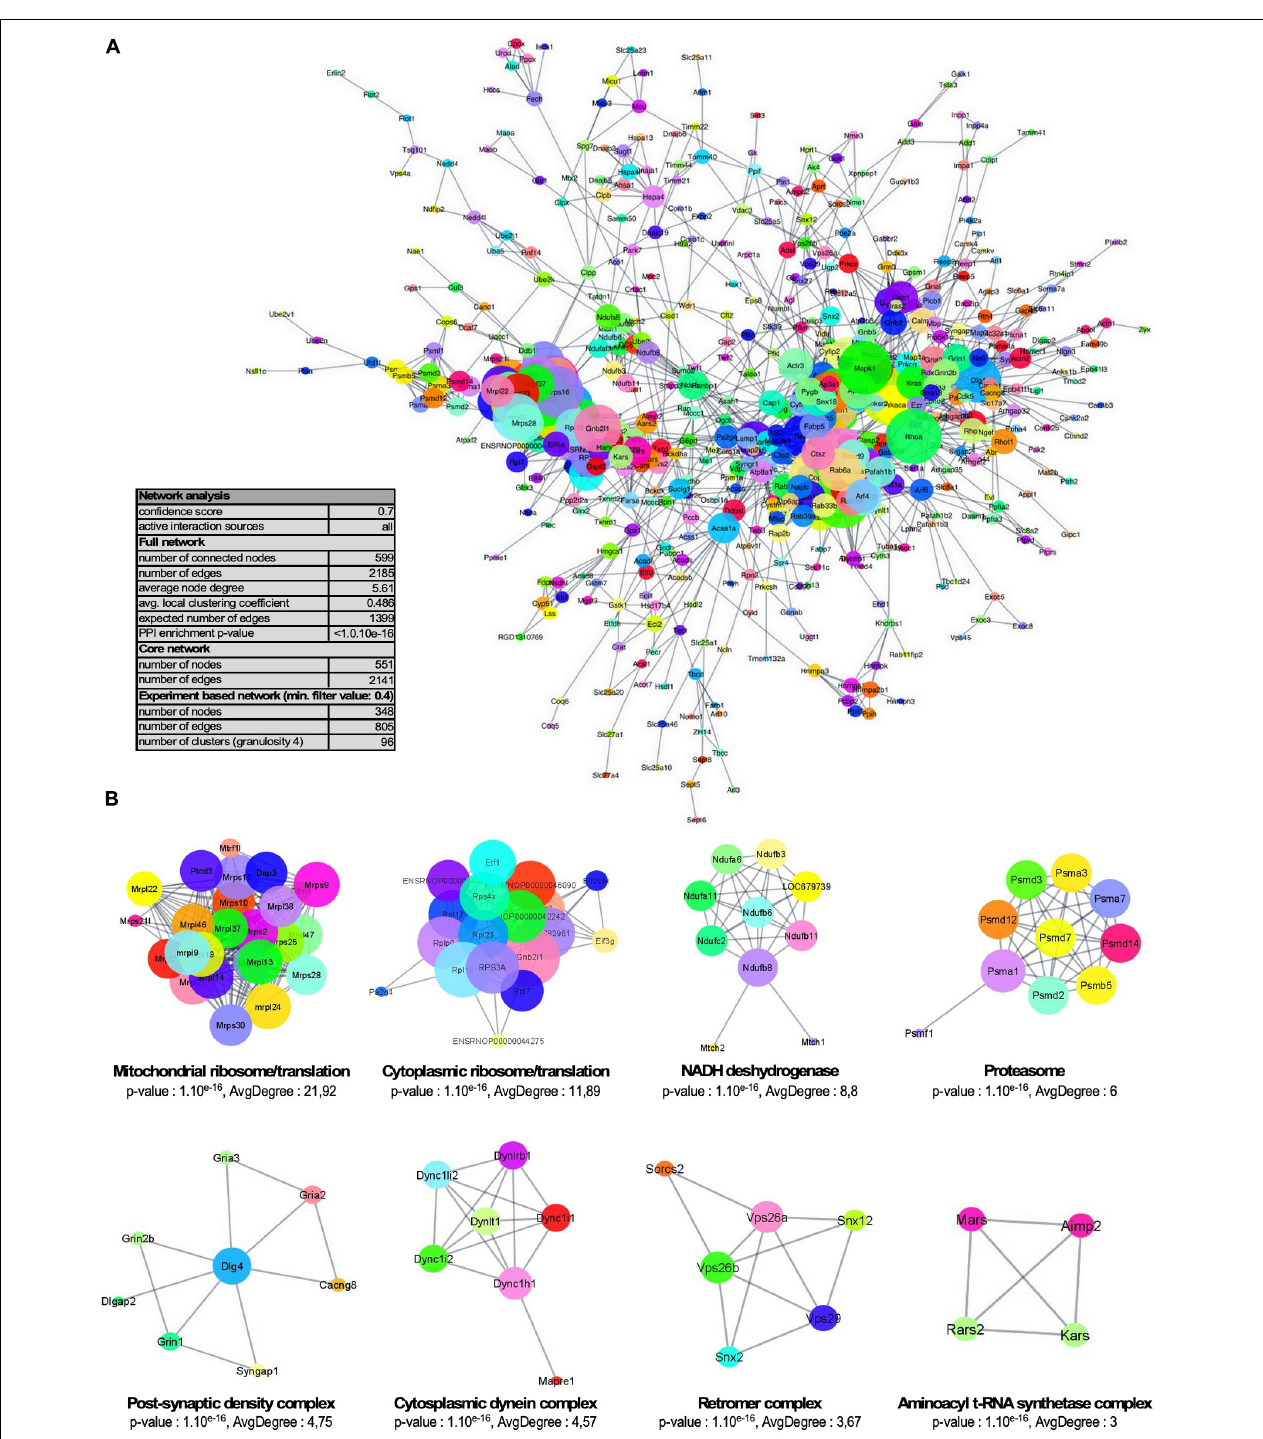
FIGURE 5 | Network organization of the synaptic SUMO2/3-ylome. (A) Core cluster obtained by STRING network analysis of all identified SUMO2/3-ylated protein candidates, with a STRING interaction confidence of 0.7 or greater on all active interaction sources. (B) STRING network was imported into the Cytoscape application through the StringApp plug-in and further filtrated for experiments edges with a confidence of 0.4 or greater. The resulting sub-complex (346 components) was subjected to MCL clustering at granulosity 4, which resulted in 96 sub-complexes including eight clusters with an average degree superior or equal to three illustrated here. Node size reflects the average node degree within the